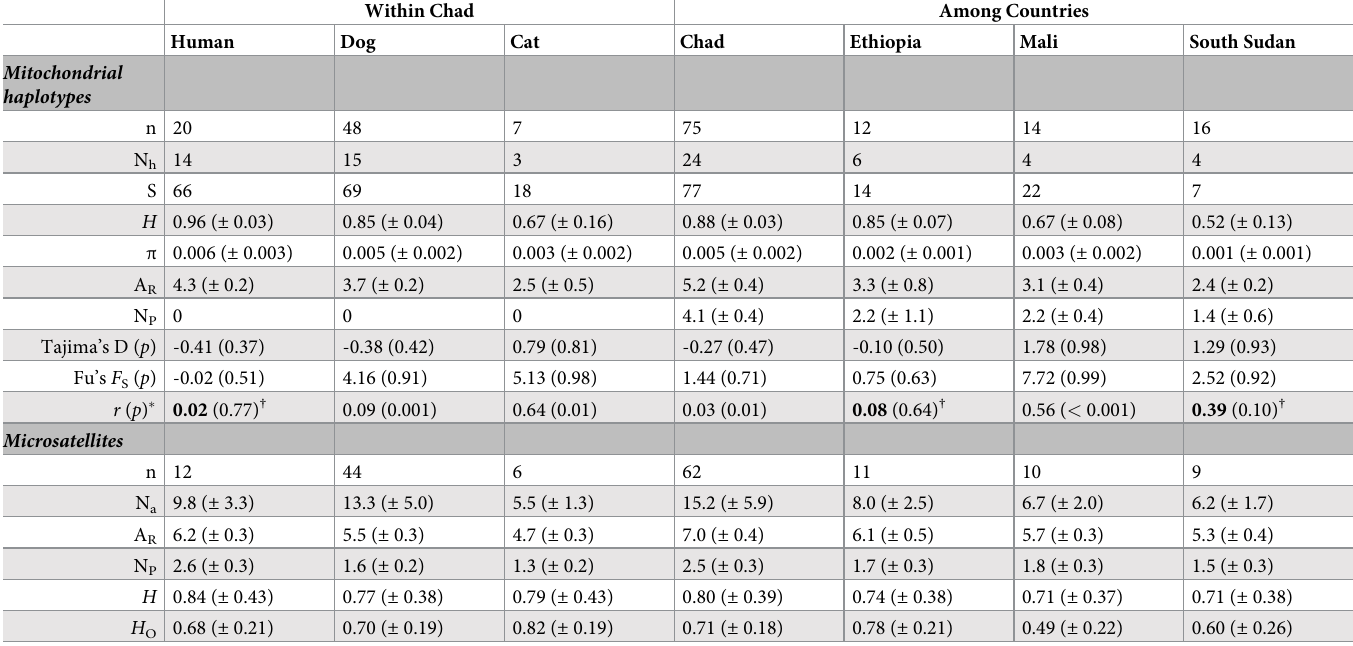
Table 1. Mitochondrial and microsatellite diversity statistics for parasites within chad (subdivided by host species) and among all four endemic countries. Within Chad Among